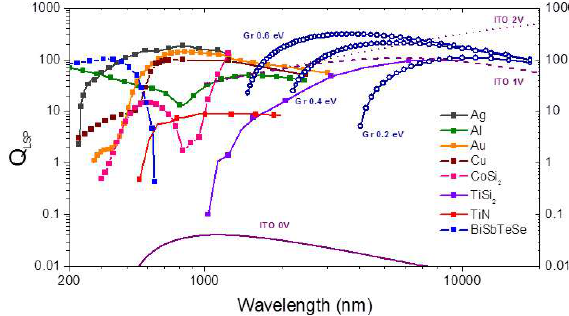
Figure 2: Figure 2 Localized surface plasmon resonance quality fac- tors determined from material properties alone, plotted as a func- tion of wavelength. In each case experimental data of permittivities were directly obtained or derived from fitting based on experimental results (data from Ref [64], Ag data from Ref [65]) with the excep- tion of graphene (abbreviated Gr), whose dielectric function was computed using the Kubo formula in the local random phase ap- proximation (RPA) limit, and assuming a relatively modest carrier lifetime of 0.4ps [67]. Backscattering due to extrinsic impurities or substrate induced effects are not included. Voltage values for ITO corresponds to the gating geometry shown in Ref [66], and trans- lates to carrier densities of 1 x 10 11 /cm 3 , 1.65 x 10 22 /cm 3 , and 2.77 x 10 22 /cm 3 respectively. The figure is meant as a general guide for fair comparison of quality of resonances in plasmonic materials, and their effective spectral